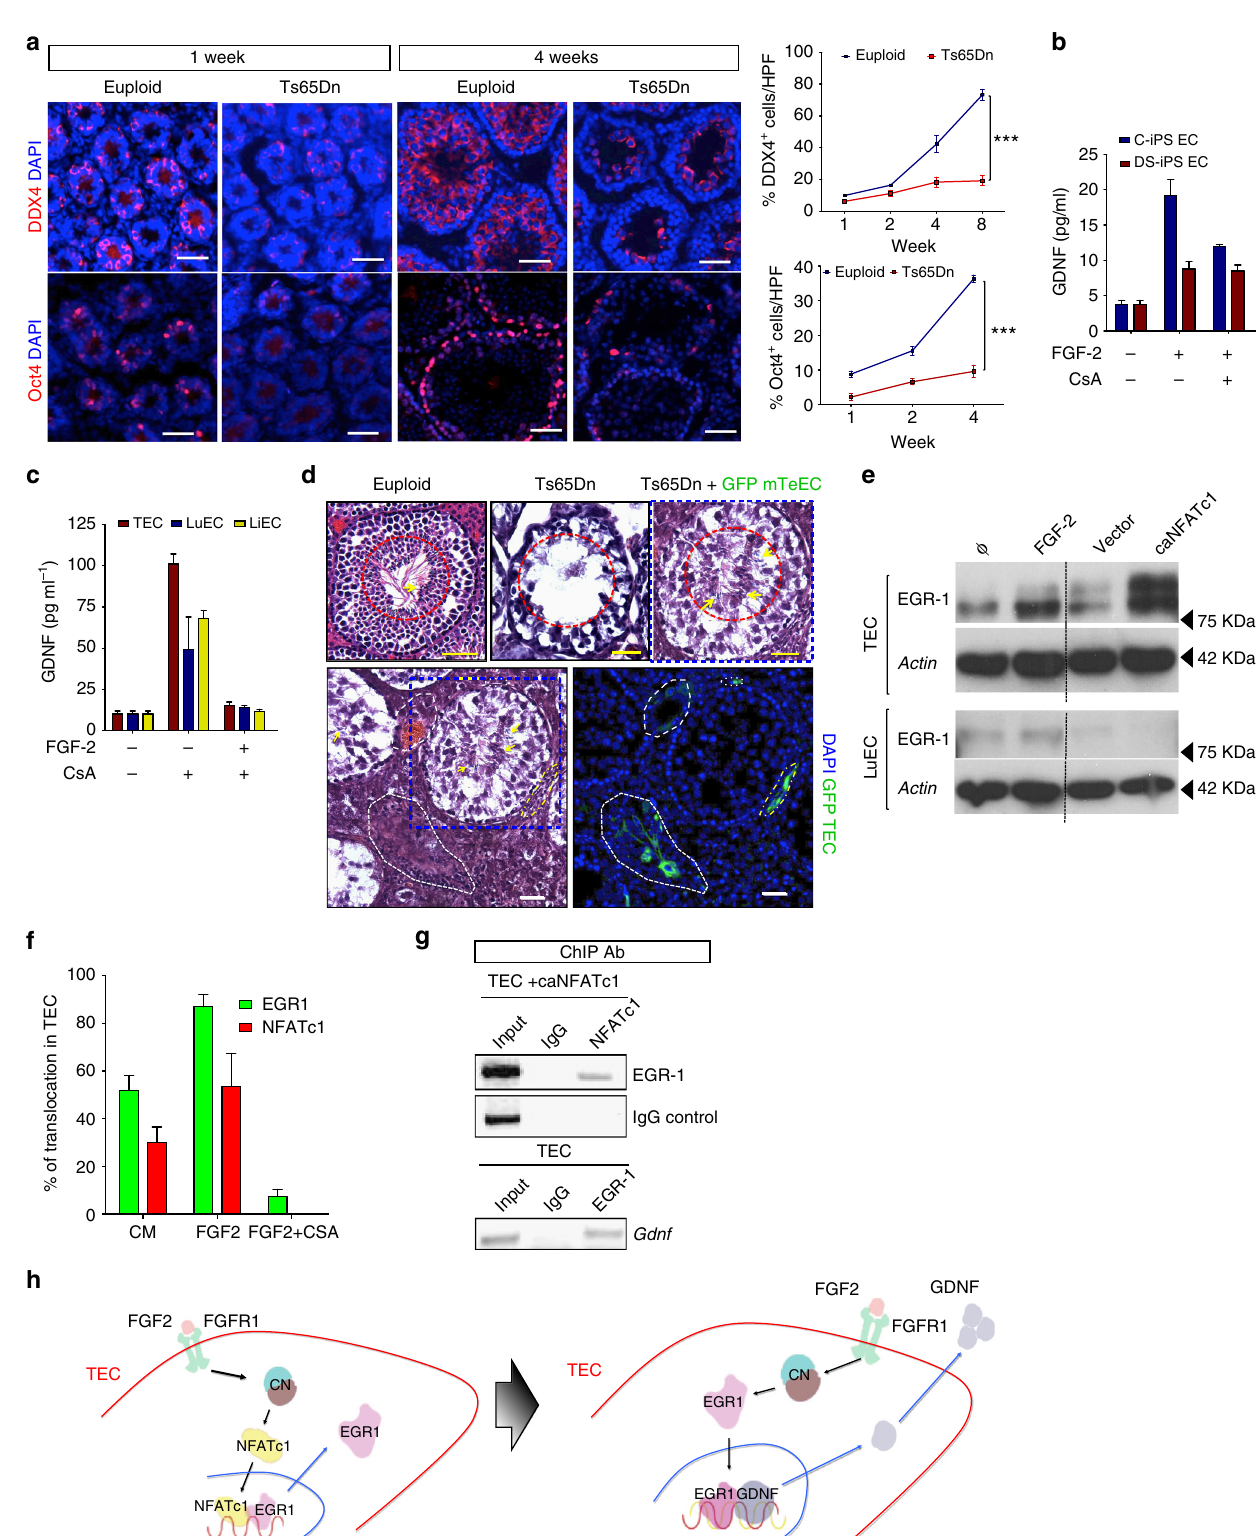
colonies 150 days after culture in vitro and labeled them with the fl uorescent dye PKH67. Our PKH-labeled putative SSCs were transplanted into busulfan-treated Nude mice. The testes were examined after transplantation of our labeled human SSCs (Fig. 6c). At 2 days after transplantation, the PKH67 + cells